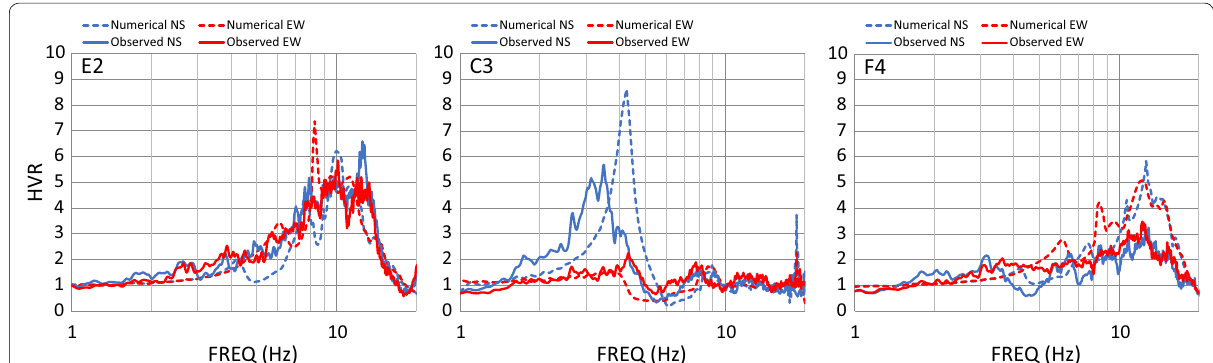
Fig. 14 Comparison of the observed MHVRs ( solid blue and red lines ) with the numerical MHVRs ( broken blue and red lines ) for points E2, C3 and F4. There is effectively no difference between NS/UD and EW/UD for points E2 and E4, and the numerical MHVRs fit the observed ones. As for point C3, the numerical MHVRs show the same directional dependence as the observed